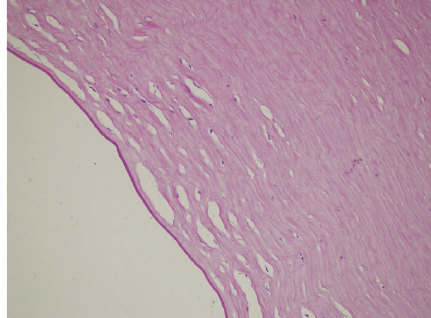
Figure 1: Light microscopy of stroma and Descemet’s mem- brane (high magnification × 400) showing cystic spaces in stroma, Descemet’s membrane irregularities, and complete absence of endo- thelial layer. 180 × 135mm (300 × 300 DPI).